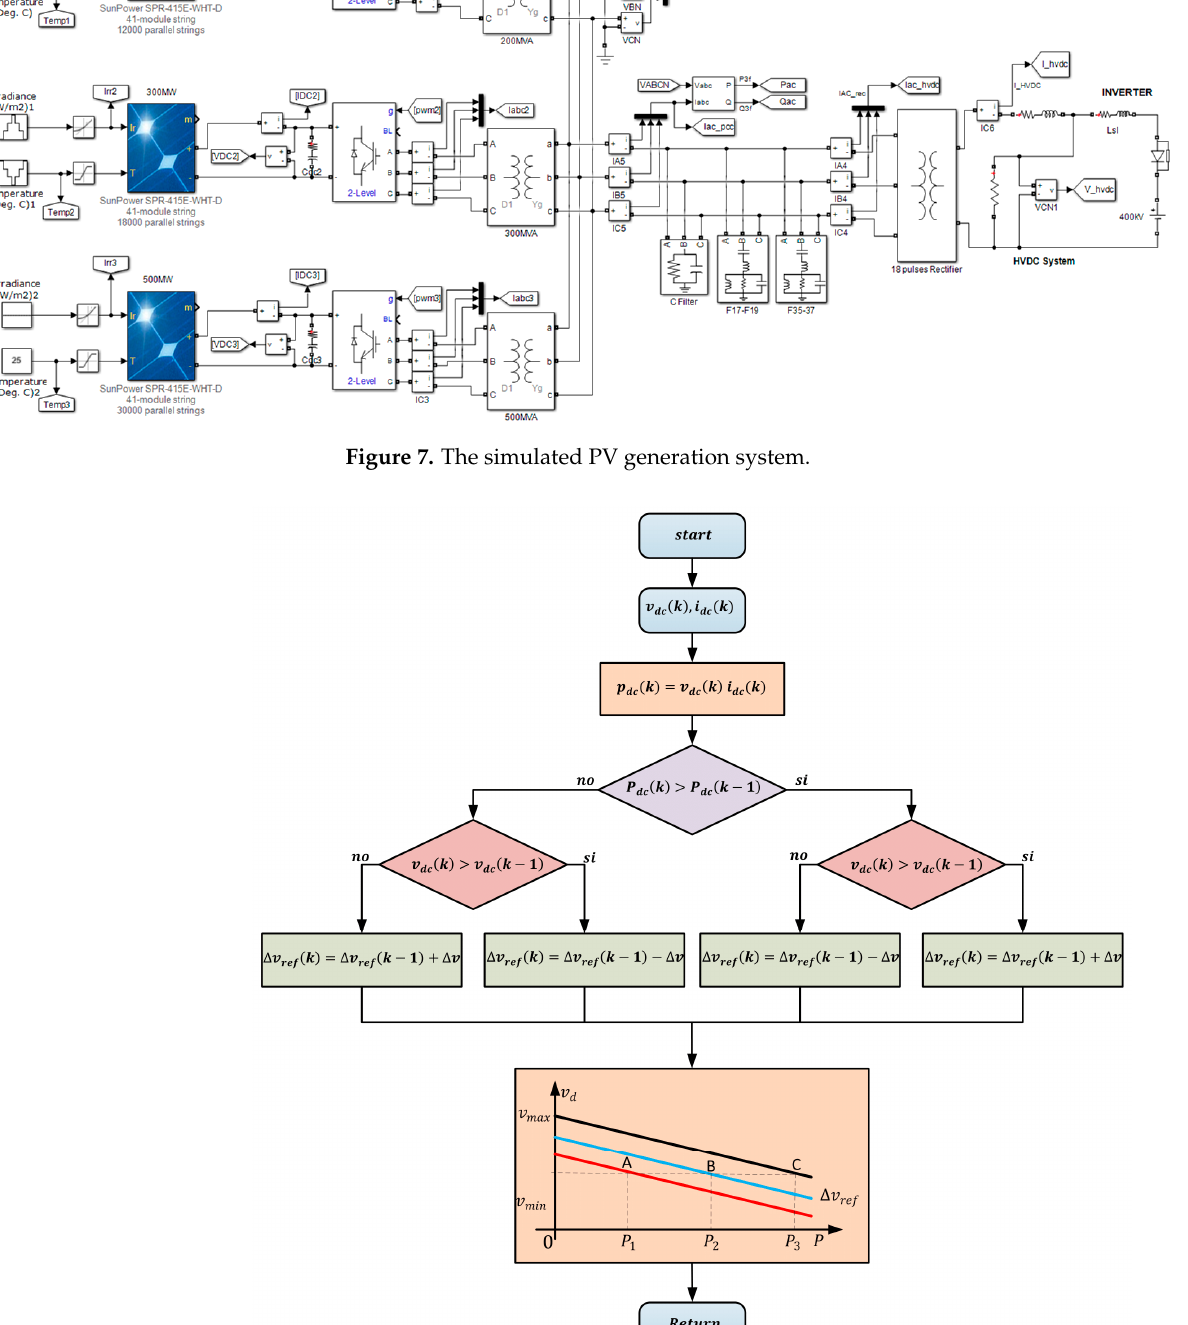
Figure 8. Flow diagram of the P&O MPPT algorithm.